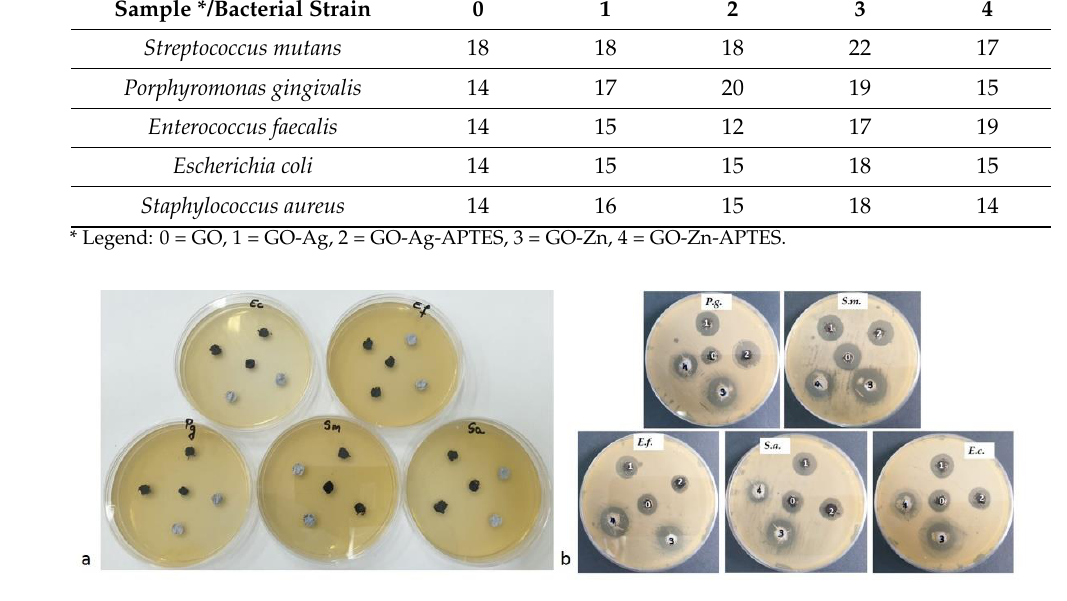
Figure 8. Images of samples ( a ) at time 0 and ( b ) after 18 h of incubation